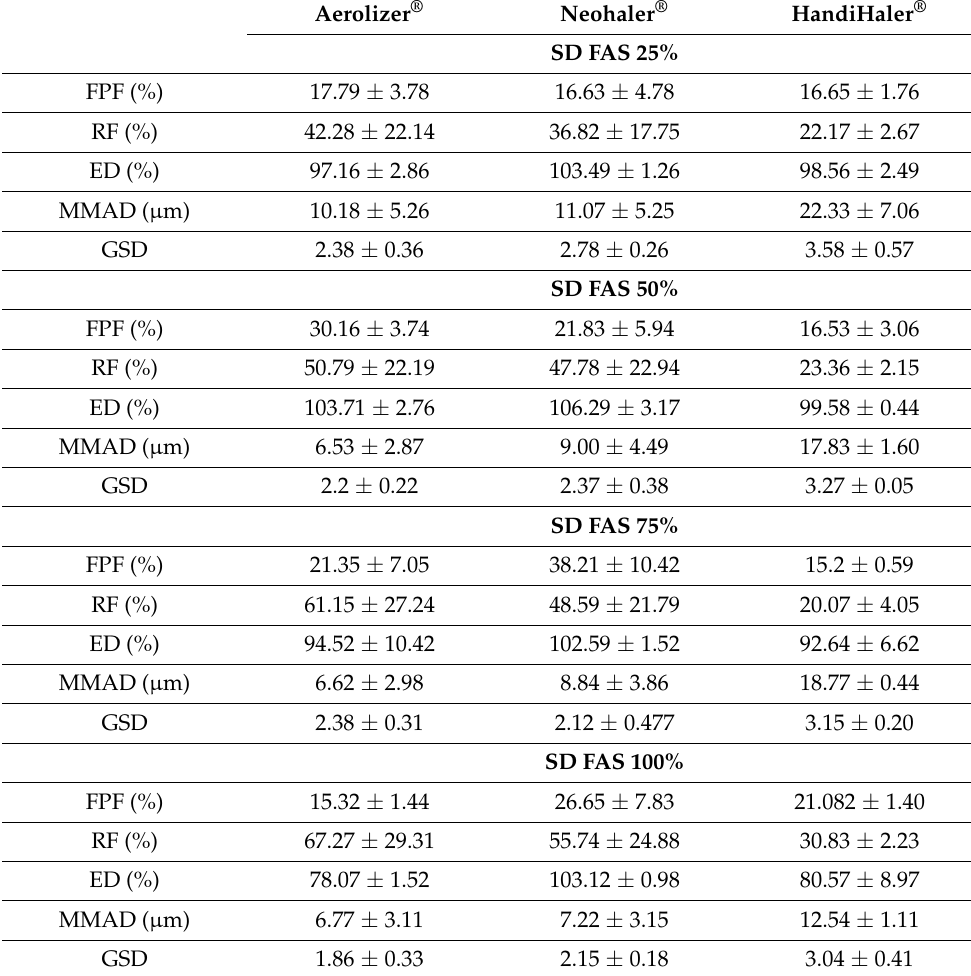
Table 5. In vitro aerosol dispersion performance properties of SD FAS powders at four different pump rates using the FDA-approved human DPI devices, Aerolizer ® , Neohaler ® and HandiHaler ®